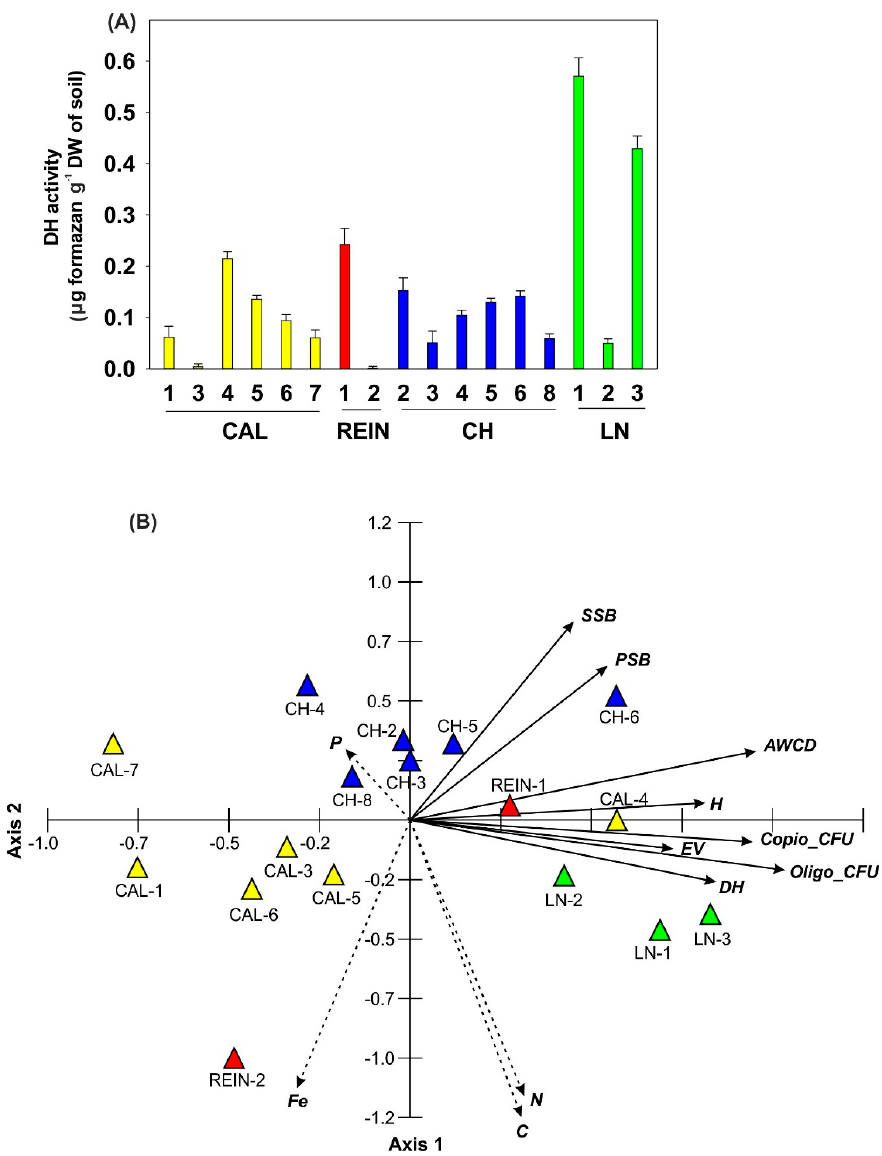
Figure 5. Soil dehydrogenase (DH) activity ( A ). PCA of the soil parameters: number of Copio, Oligo, SSB, and PSB, AWCD index, H index, and DH activity, and concentration of C, N, P, and Fe ( B ).